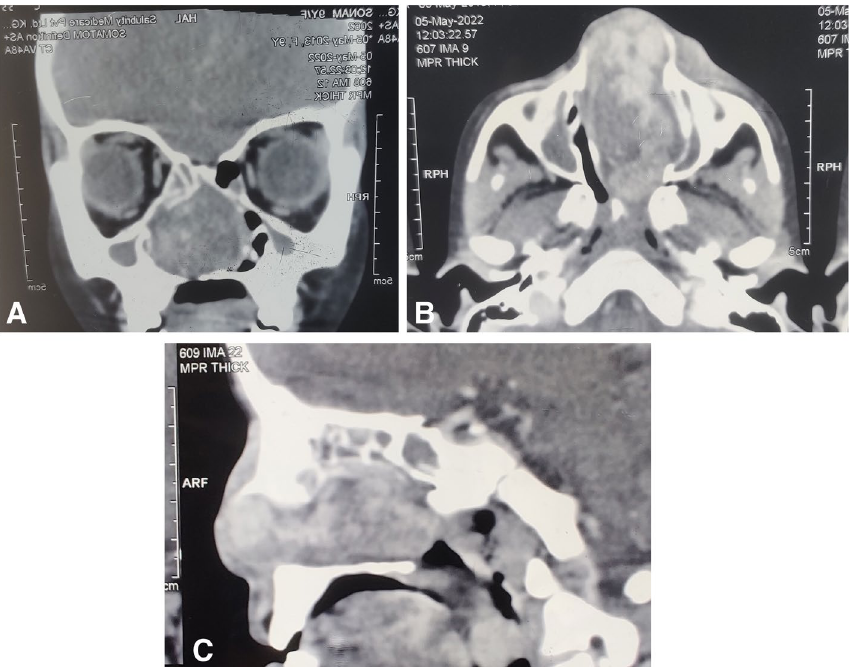
Fig. 3 A–C Computed tomography scans of nose and paranasal sinuses at presentation. a Coronal section. b Sagittal section. c Axial section—a heterogeneously enhanced expansile mass seen in left nasal cavity filling up to left choana, pushing the septum completely to